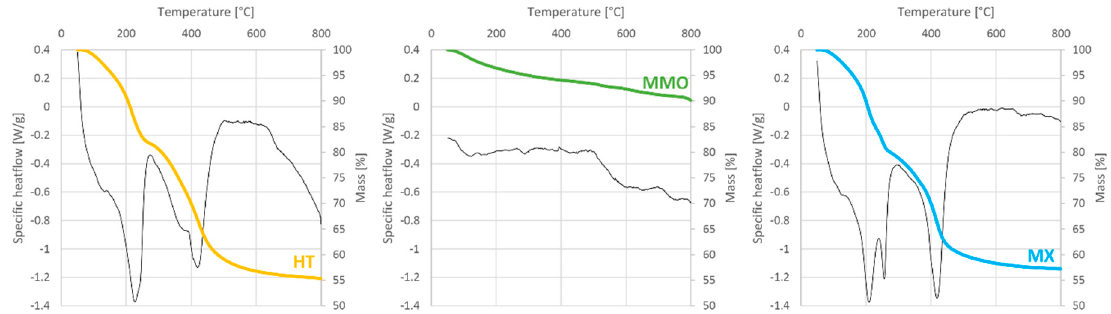
Figure 3. TGA (colored lines) and DSC (black lines, exo up) curves of the prepared catalysts.